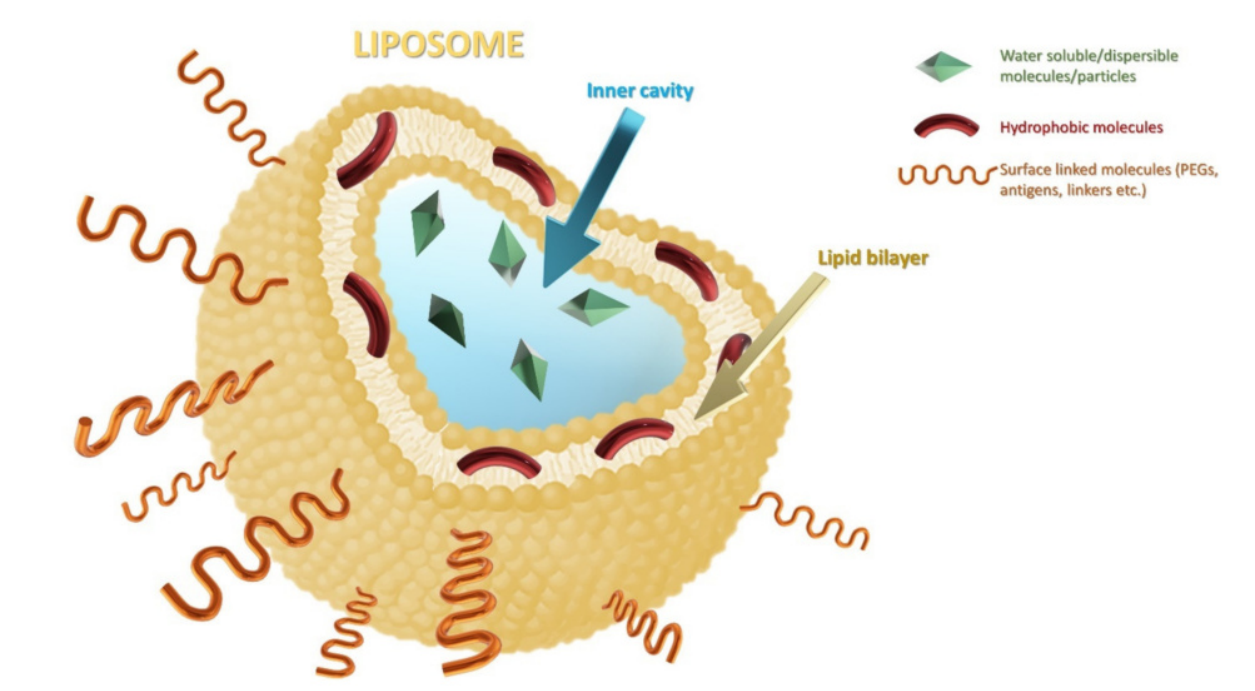
Figure 9. General schematic representation of a liposome structure.